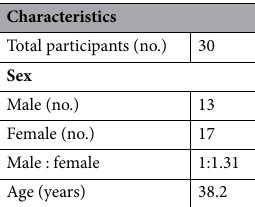
Table 1. Demographics of the participants No number of patients, y year